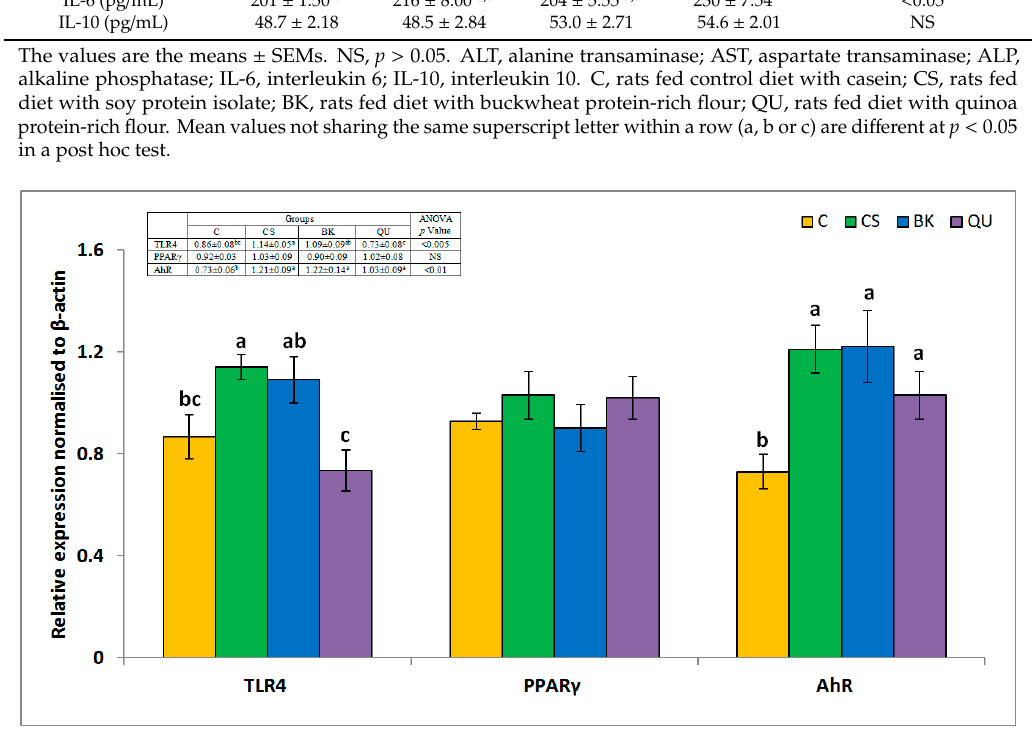
Figure 1. mRNA expression of selected factors related to immune–metabolic mechanisms in the livers of rats fed experimental diets. The values are the means ± SEMs. NS, p > 0.05. Mean values not